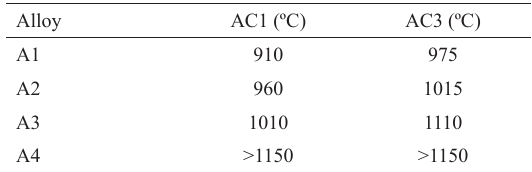
Table 2: α/γ transformation